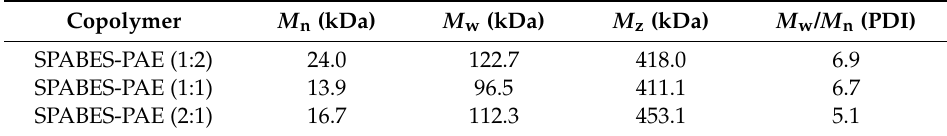
Table 2. The mechanical behaviors and glass transition temperature of block copolymers.